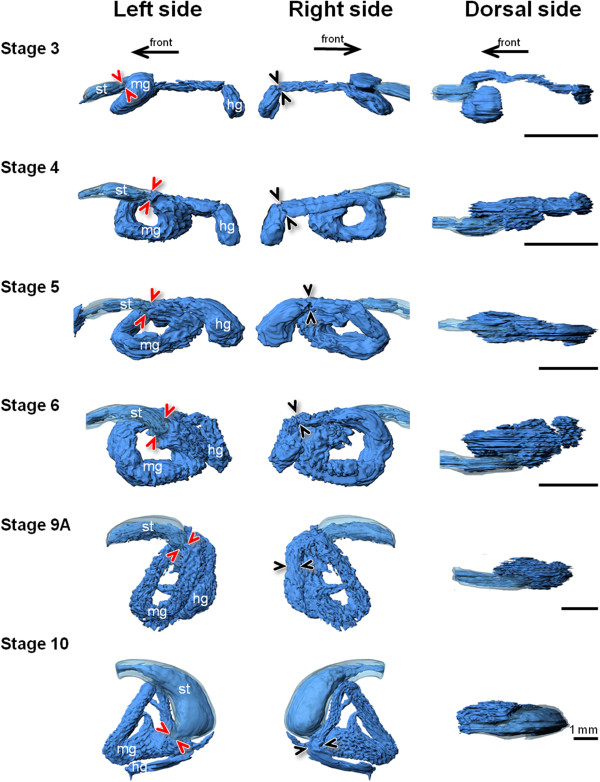
Ontogeny of presumptive stomach (transparent light blue) and GI-tract lumen (blue) in Atlantic halibut larvae. 3D models were reconstructed from serial histological sections using Imaris software. GI-tract lumen is represented by the inner layer (facing the lumen) of the GI-tract. The GI-tract is seen from three angles; left, right, and dorsal side. Arrows indicate the anterior direction (mouth). Arrow heads point to position of sphincters (red: pyloric sphincter; black: ileorectal sphincter). st presumptive stomach/stomach, mg midgut, hg hindgut.